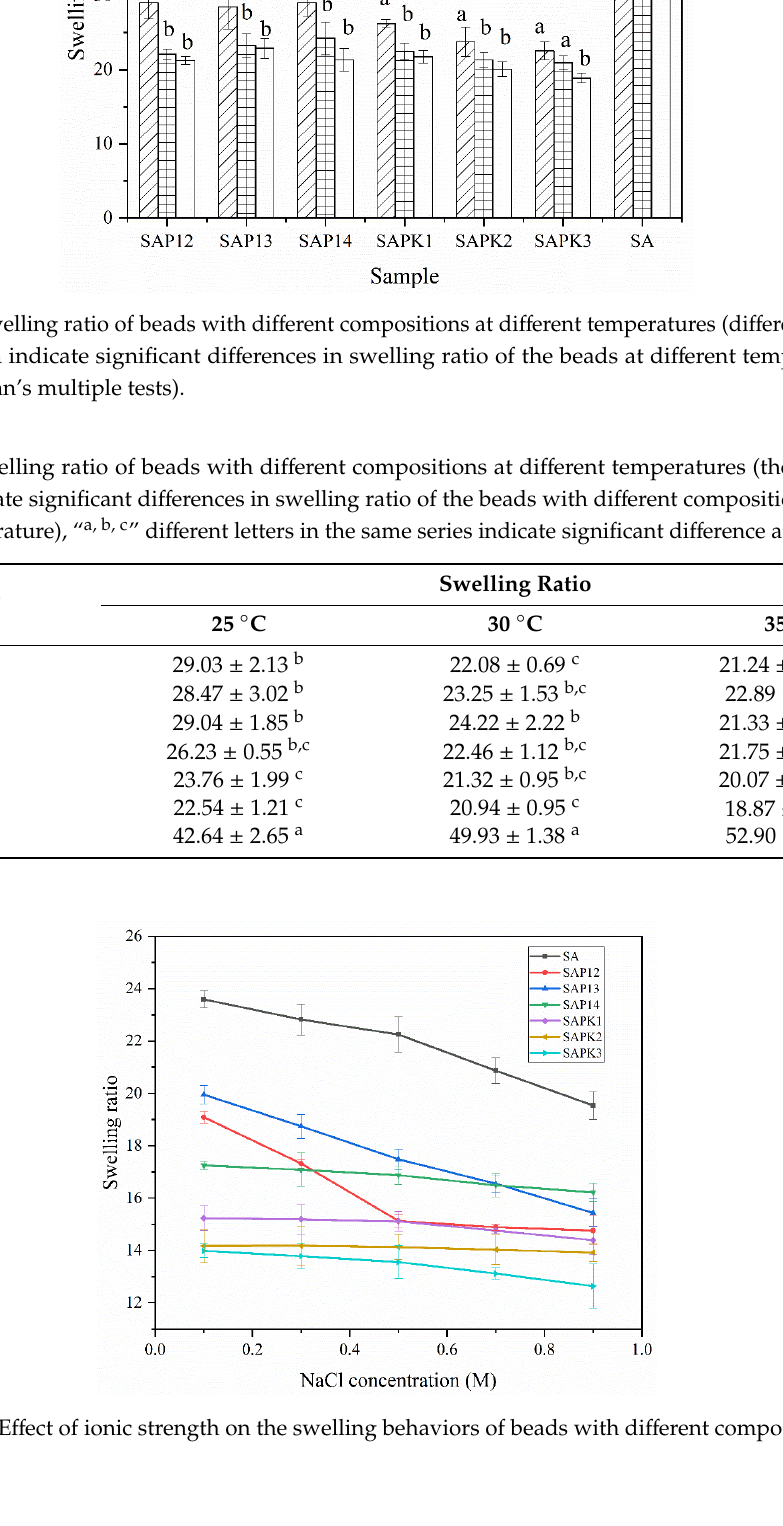
Figure 7. pH ‐ dependent swelling behaviors of beads with different compositions. 3.4. Rheological Properties